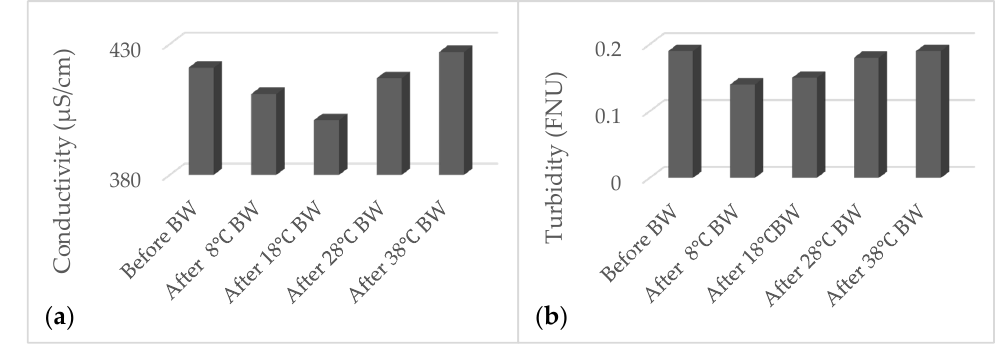
Figure 6. Treated effluent physicochemical parameters of ( a ) conductivity and ( b ) before and after water backwash at temperatures of 8 °C, 18 °C, 28 °C and 38 °C. Each mean value is derived from 6–10 repetitions.